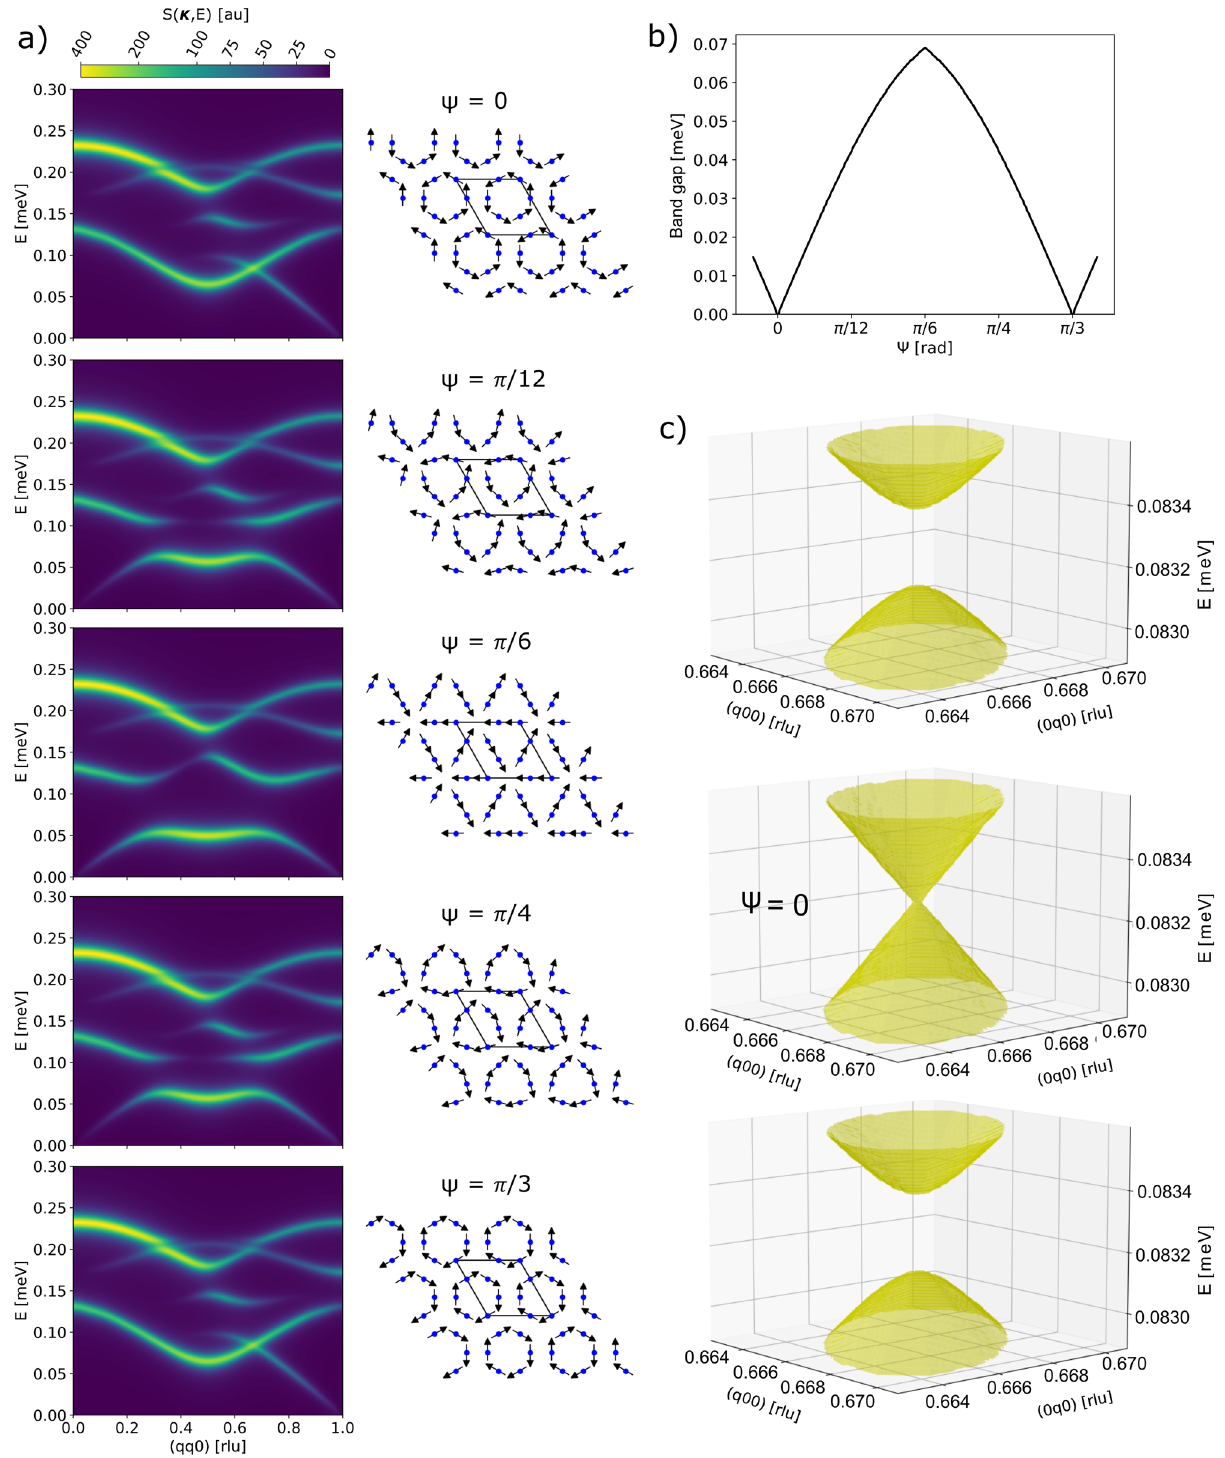
Fig. 3 Magnon gap in the dipolar honeycomb lattice. a Simulation of the inelastic neutron cross-section S ( κ , E ) along the momentum transfer κ = ( q , q , 0) for selected Ψ . Note the opening of a gap at κ = (2/3, 2/3, 0) between the acoustic and the lowest optical mode at the energy E ≈ 0.083 meV when the spin con fi guration given by angle Ψ is varied. The color bar represents the calculated intensity of the inelastic neutron cross-section. b Dependence of the magnon band gap as a function Ψ at κ = (2/3, 2/3, 0). c Calculation of the spin-wave dispersion close to the Dirac point for Ψ = − 5.6 × 10 − 4 π , 0, and + 5.6 × 10 − 4 π ,